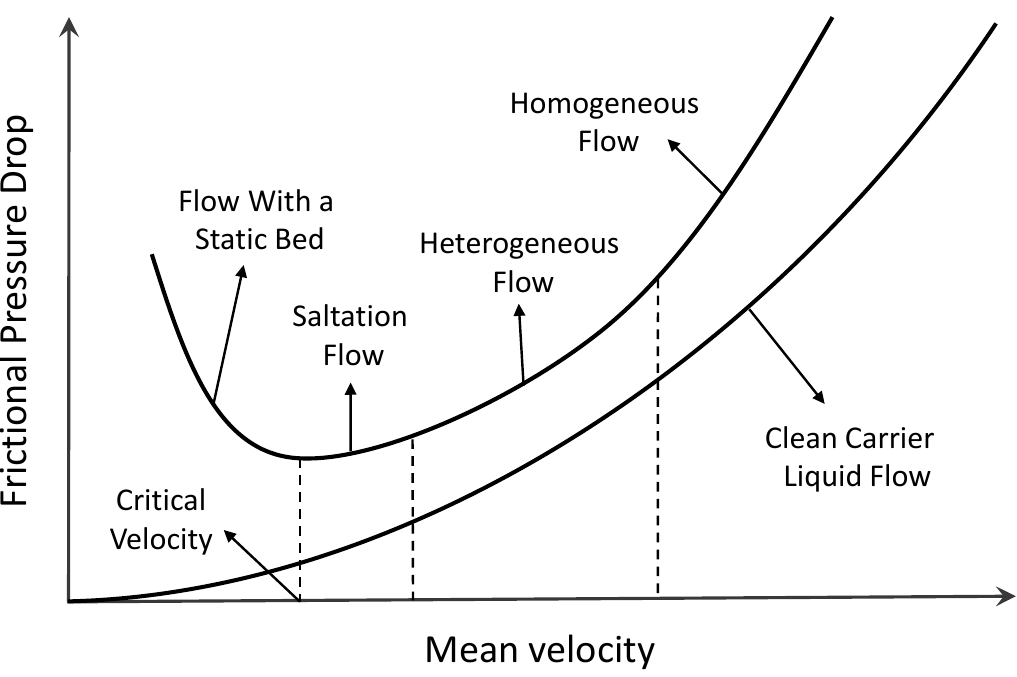
Figure 3. Frictional pressure drop as a function of mean velocity for different slurry flow regimes. At low flow rates, the turbulent eddies are not strong enough to suspend the solid phase. As a result, a considerable portion of the pipe is occupied by stationary sedi- mentation bed above which there is a heterogeneous layer with a recognizable solids concentration gradients. This regime of the slurry flow is also referred to as the bed-load regime. As observed in Figure 3 the frictional pressure drop decreases with the mean